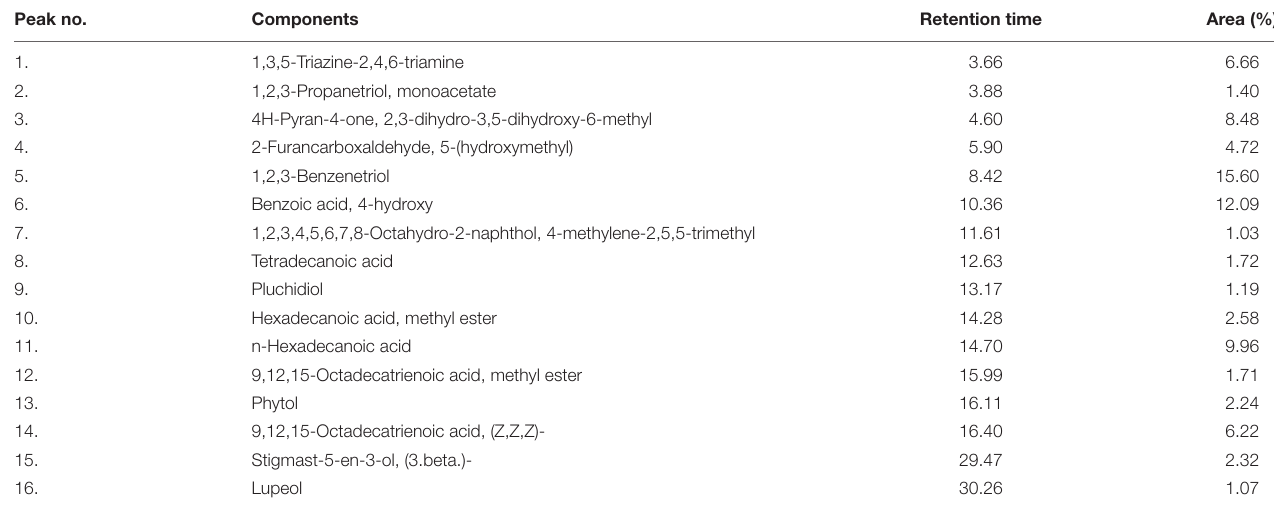
TABLE 4 | Phytochemicals of Mangifera indica extract as identified by GC-MS analysis. Peak